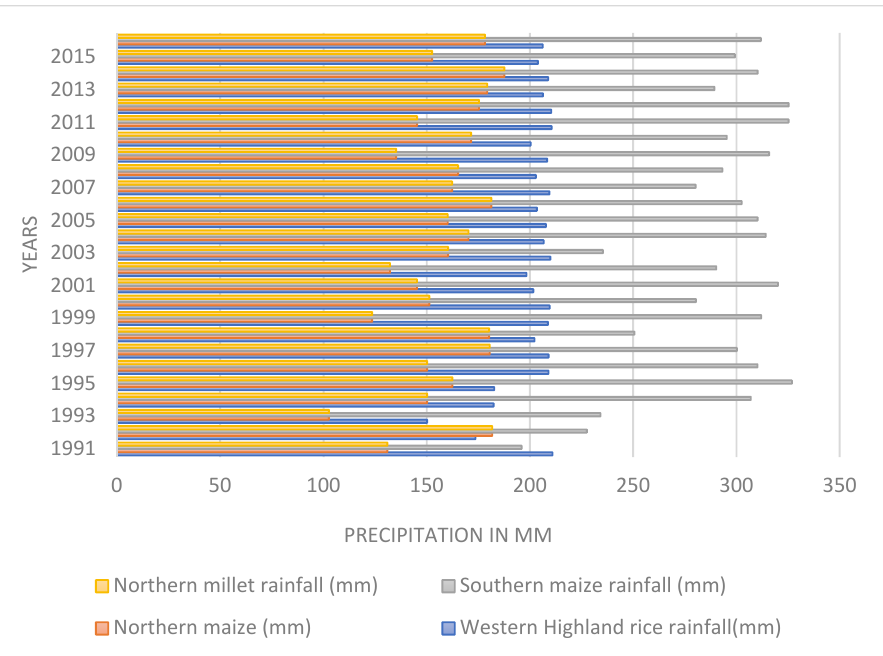
Figure 8. Sub-national Growing Season Precipitation Trends for Western Highland Rice, Southern maize, Northern maize, and millet.